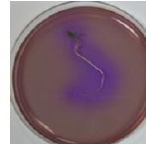
Table 4. Apparent activation of proton pump of tomato seedlings based on the bromocresol